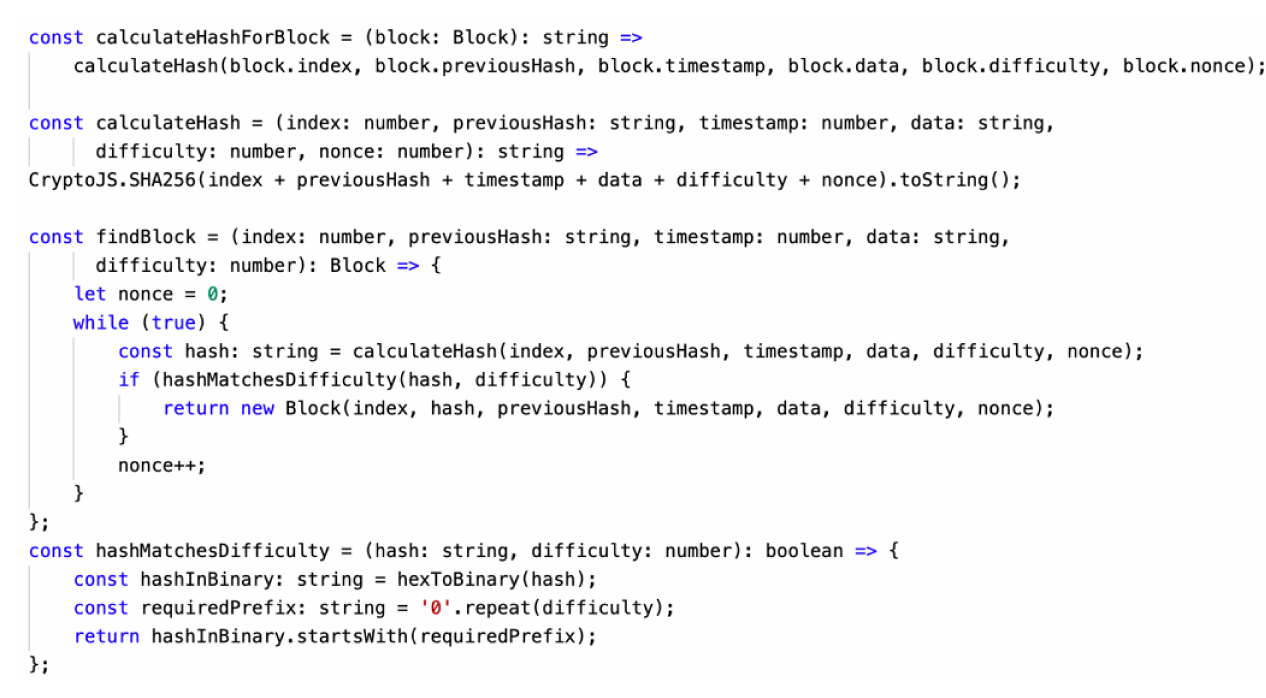
Figure 6. Major Functions for PoW consensus algorithm.